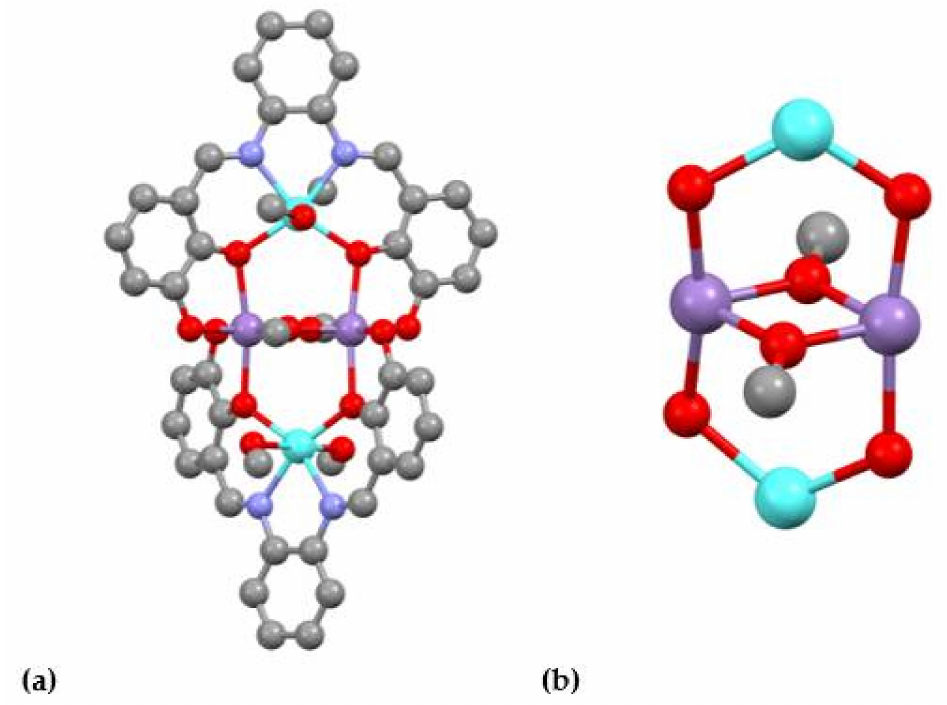
Figure 5. Crystal structure of SYML2-Mn. ( a ) Molecule, without hydrogens for clarity. Carbon: gray. Oxygen: red. Nitrogen: blue. Mn(II): cyan. Mn(III): purple. ( b ) The Mn-oxide core showing the two methoxo